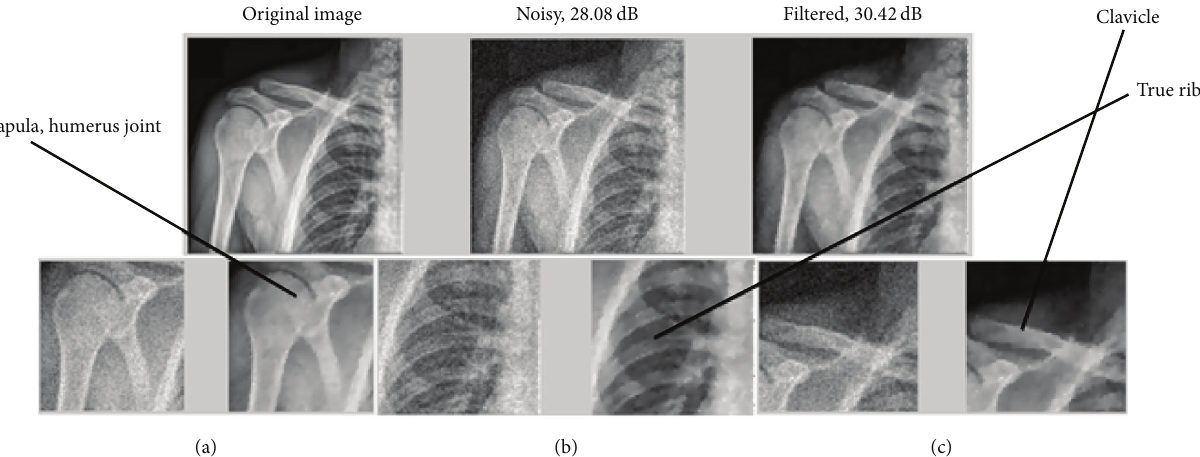
Figure 15: Results showing the original image, its noisy counterpart, and the denoised image and its various magnified portions of various sections of the denoised image of human skeleton. Image size = 512 × 512; the filter settings are as follows: Sigma ( 𝜎 ) for random noise = 12, number of iterations = 4, 𝜆 in (3) = 1/7, and Kappa ( 𝜅 ) in (4) = 15. (a), (b), and (c) show the zoomed insets of the scapula-humerus joint, true rib region, and the clavicle bone, respectively.